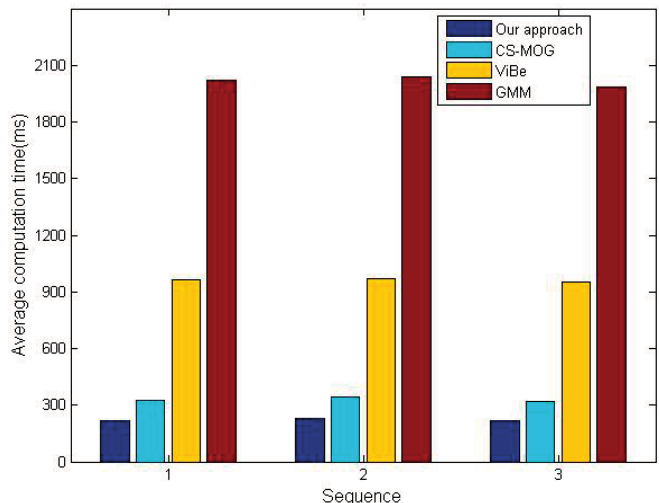
Figure 12. Average computation times (ms) of four